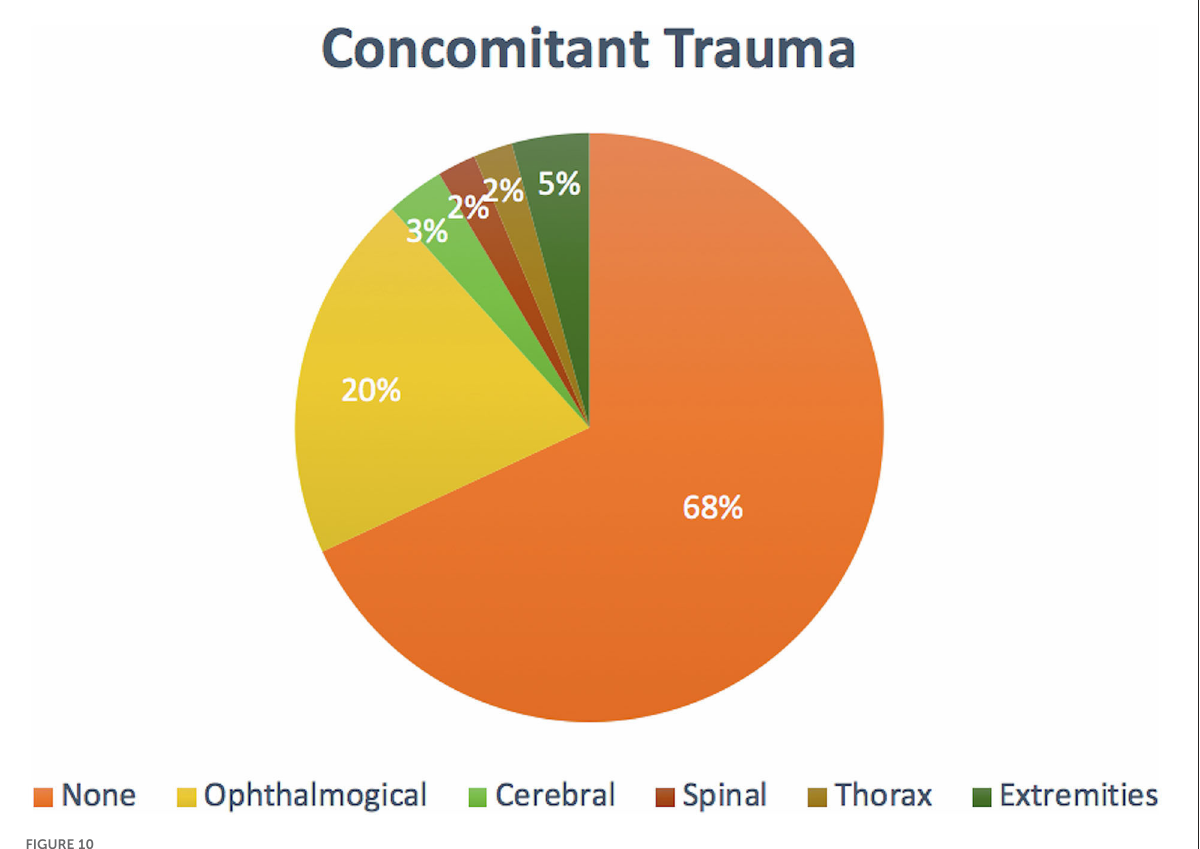
FIGURE10 Population distribution of patients sustaining concomitant trauma.